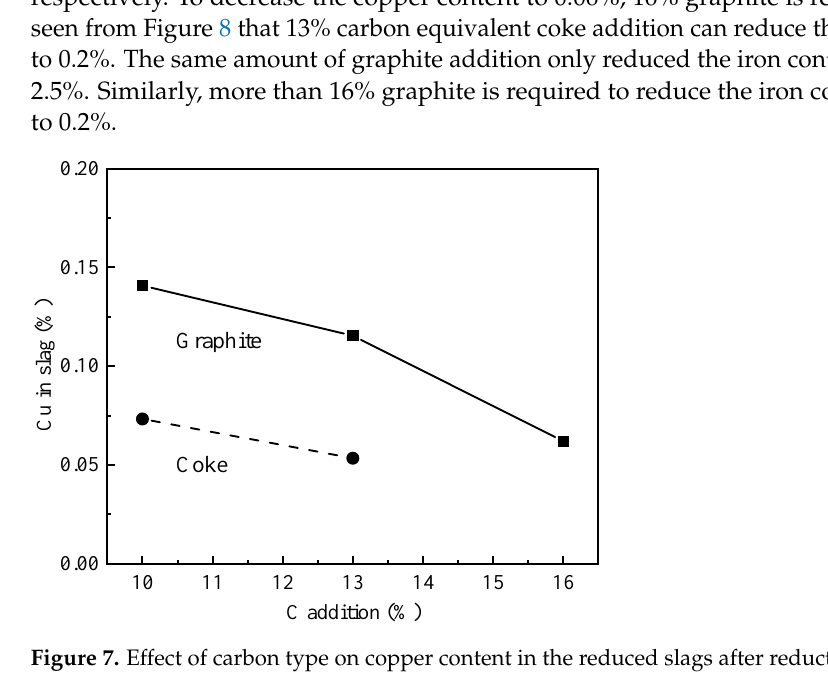
Figure 7. Effect of carbon type on copper content in the reduced slags after reduction at 1400 °C and 5% CaO addition.